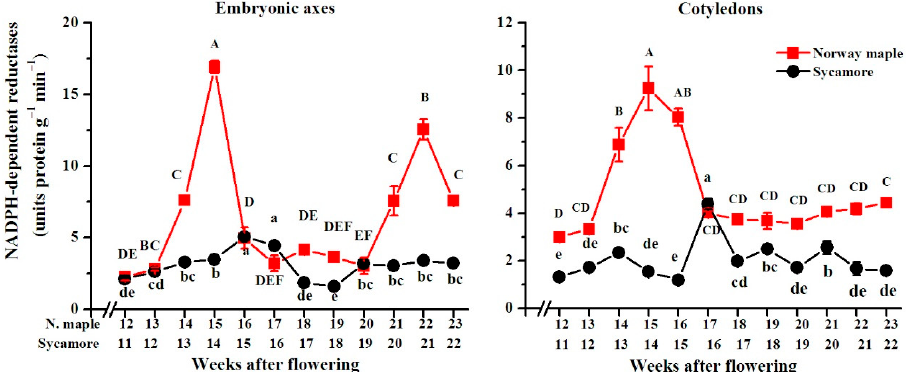
Figure 6. Changes in the activity of total NADPH-dependent reductases reported in the embryonic axes and cotyledons of developing seeds of Norway maple (squares) and sycamore (circles) collected during the 11th–23rd weeks after flowering. Data are the means of three independent replicates ± the standard error. Statistically significant di ff erences are indicated with di ff erent letters (one-way ANOVA, followed by Tukey’s test at p < 0.05). The capital letters refer to Norway